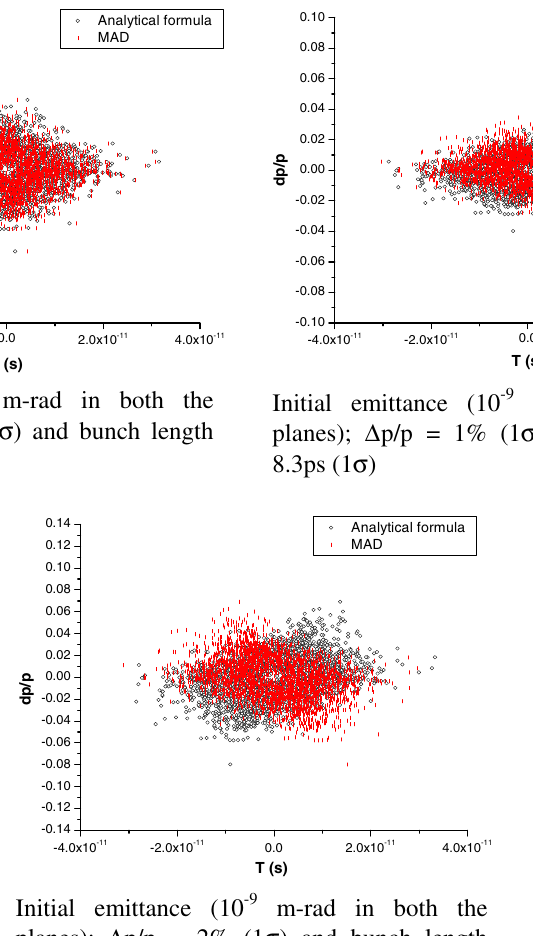
FIG. 6. Longitudinal phase space after passing from the magnet (obtained from MAD and